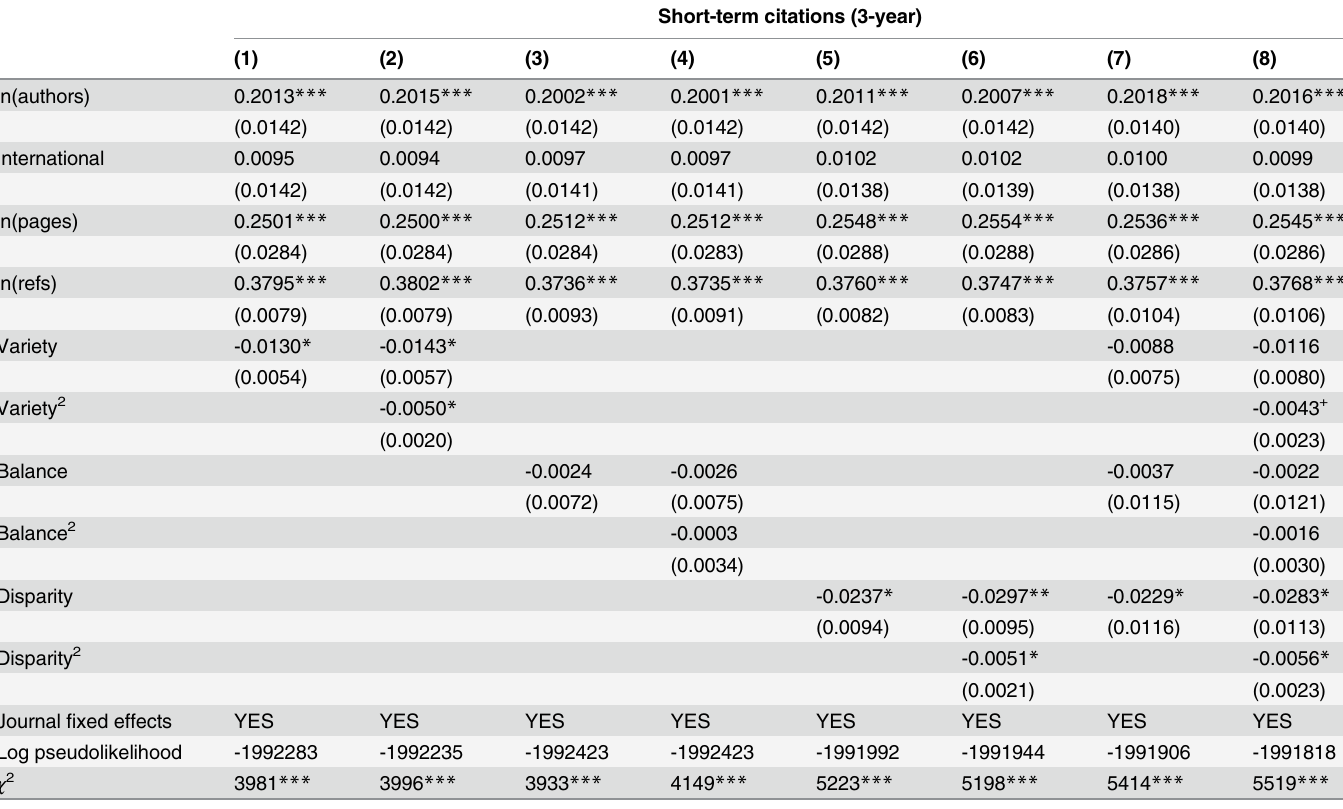
Table 6. Fixed Effects Poisson Models: Interdisciplinarity and Short-Term Impact ( N =